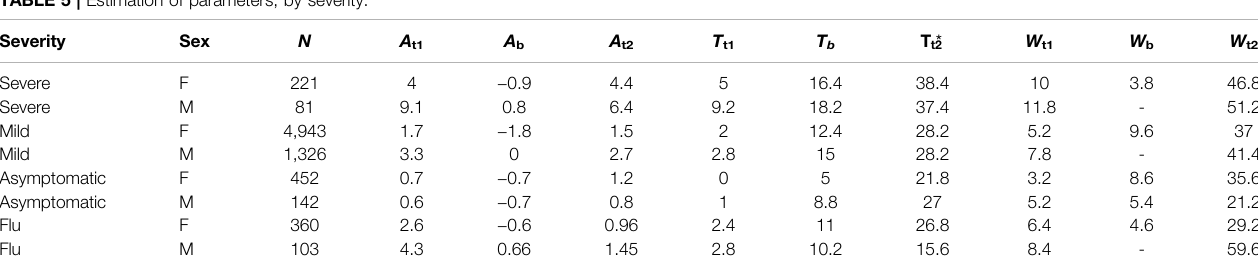
TABLE 5 | Estimation of parameters, by